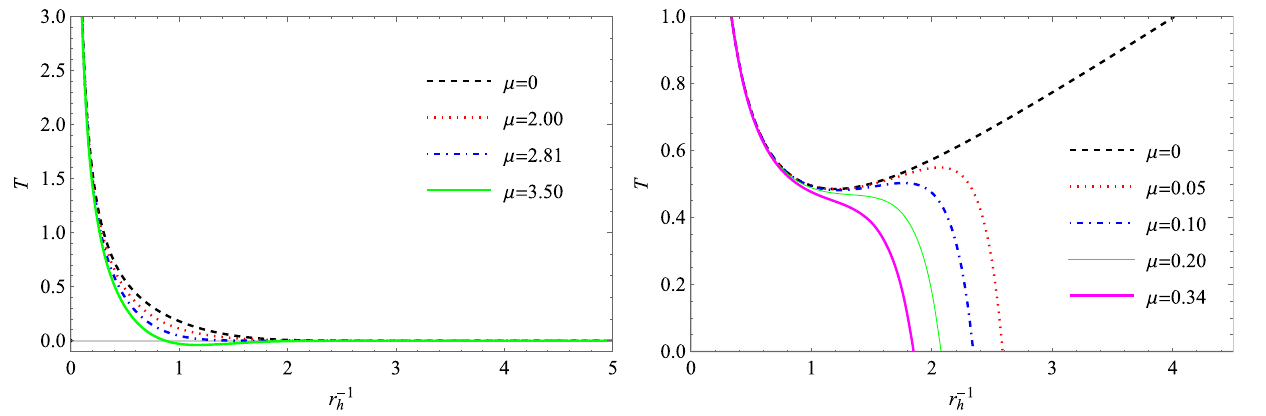
Fig. 2 Left panel: temperature versus r − 1 values of μ . The value μ = 2 . 81 corresponds to a critical chemical potential. For μ > μ c the temperature would become negative. Right